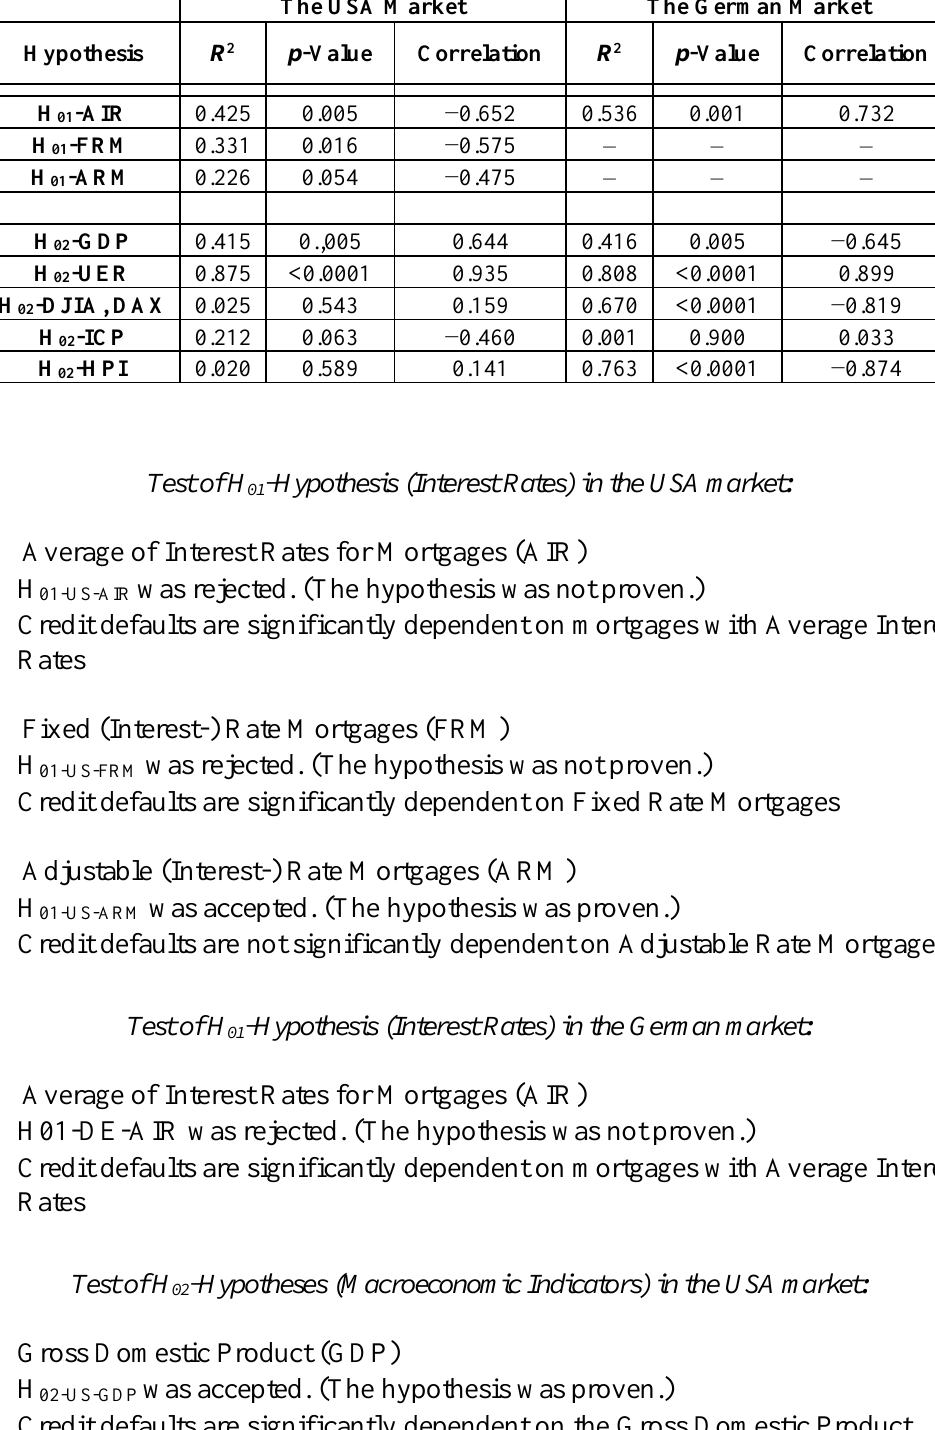
Table 2. Comparison of Hypotheses-Tests in the USA and Germany (developed by the author) The USA Market The German Market